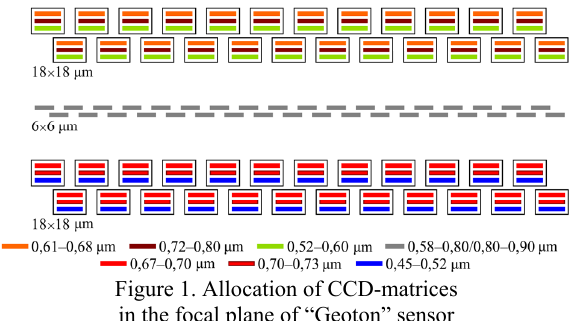
Figure 1. Allocation of